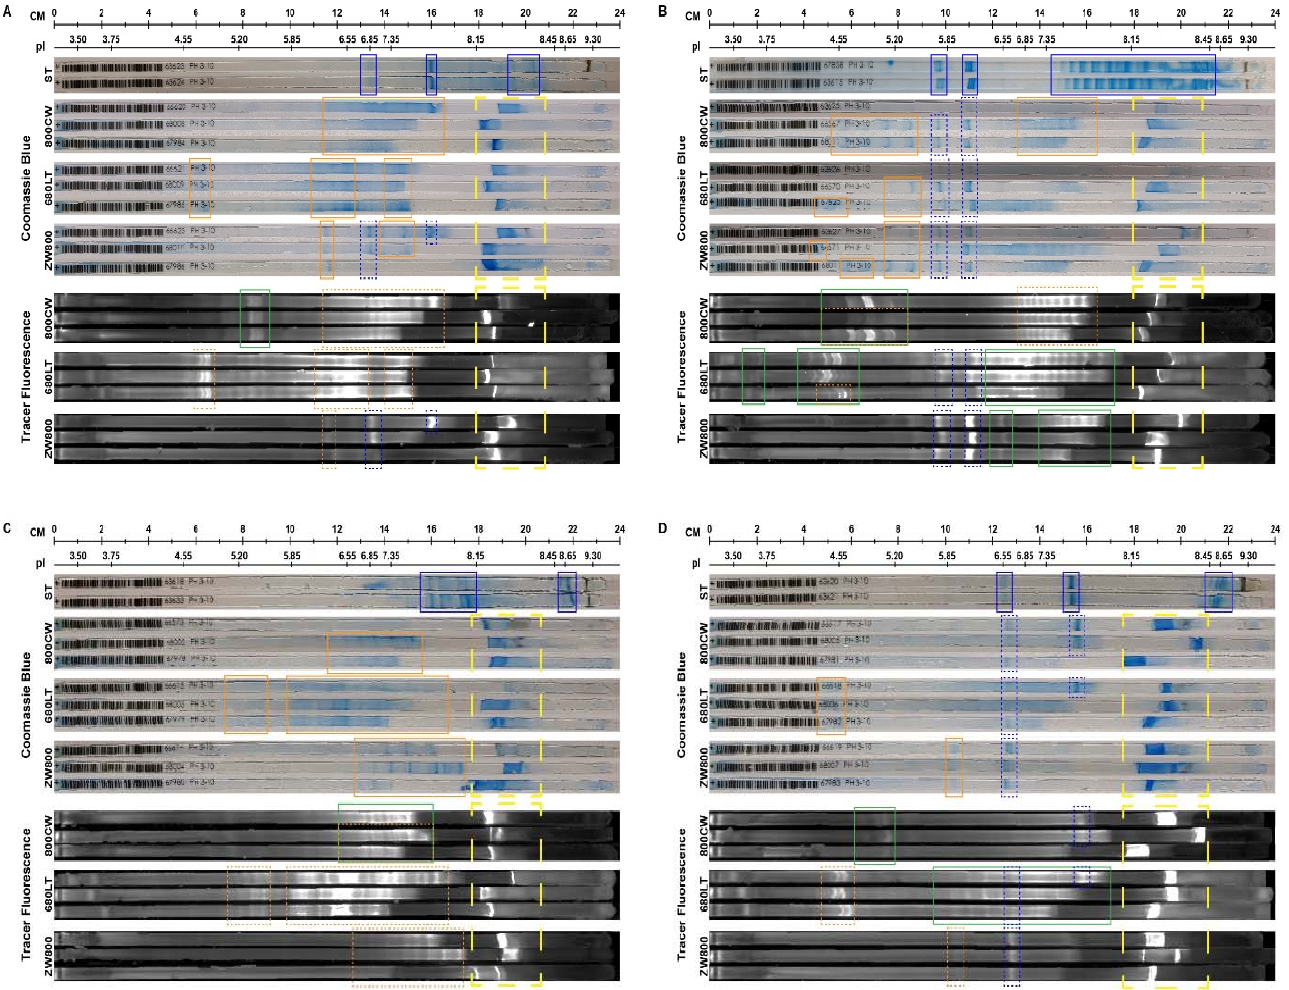
Figure 5. Coomassie blue stain and fluorescent imaging results of completed immobilized pH gradient (IPG) strips. Unmodified reference (ST) and samples from each conjugate (800CW, 680LT, ZW800) were run on separate IPG strips. pI bands and patterns for each reference antibody are highlighted with a solid blue outline. In tracer strips with coomassie, bands that correspond to the reference antibody are given a dotted blue outline, while bands that are seen only after conjugation are given a solid orange outline. In tracer fluorescence, green solid outlines correspond to bands and patterns visible on the fluorescent scans but not on the coomassie-stained strips. Dotted blue and orange outlines correspond to bands marked before with solid blue and orange outlines in reference antibody or coomassie-stained conjugated samples, respectively. The dashed yellow outline highlights areas of the gel that are aspecifically stained as a result of antibody buffer components. Infliximab ( B ) and Ustekinumab ( D ) showed the best retention of their native bands, but all conjugations (vedolizumab ( A ), infliximab ( B ), adalimumab ( C ), ustekinumab ( D )) resulted in shifts in primary band pI and formation of new bands. Infliximab showed much more acidic bands both natively and especially after conjugation to dyes. Extensive acidic shift may be related to instability in the conjugated protein. The scale of the gels is shown in cm and in pI. pI scale was based on a pI standard ladder (not shown) run on the same system alongside the samples. pI’s of sample bands are interpolated based on the position on the gel and the distribution of pI’s in the pI